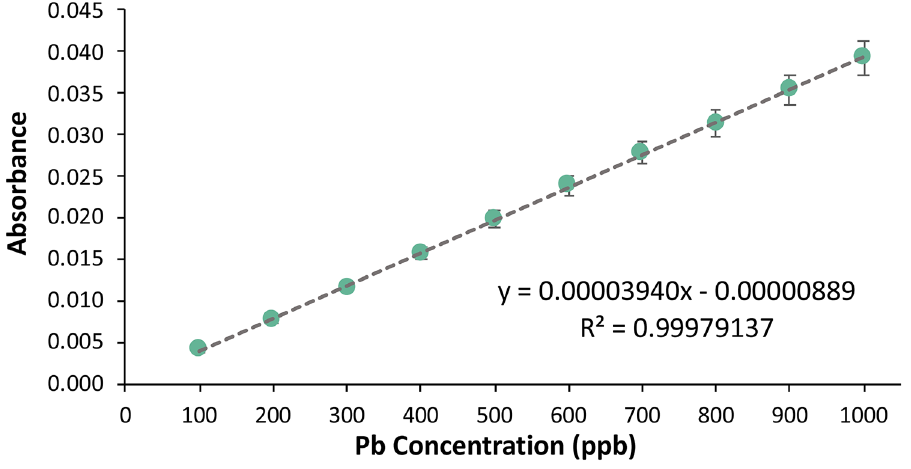
Figure 17. Pb calibration curve via AAS.